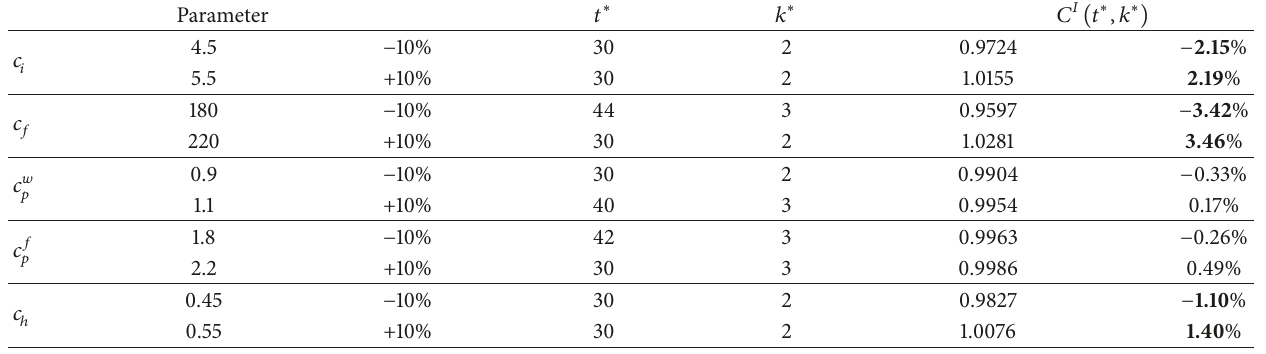
Table 7: Sensitivity analysis results.